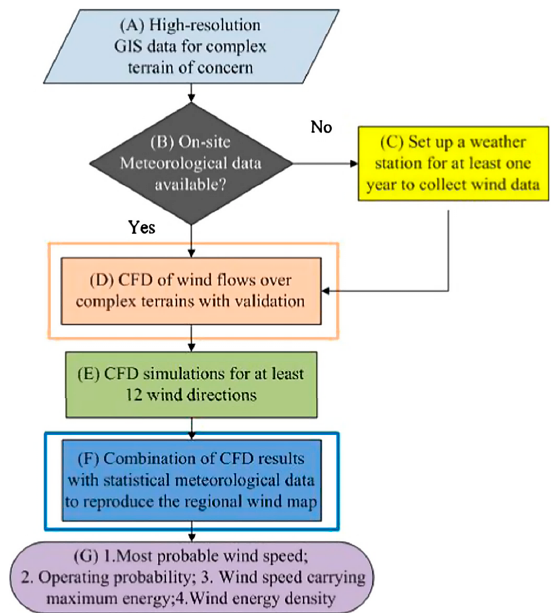
Figure 18. The methodology used for potential wind energy assessment with coupled CFD/on-site measurement [95].